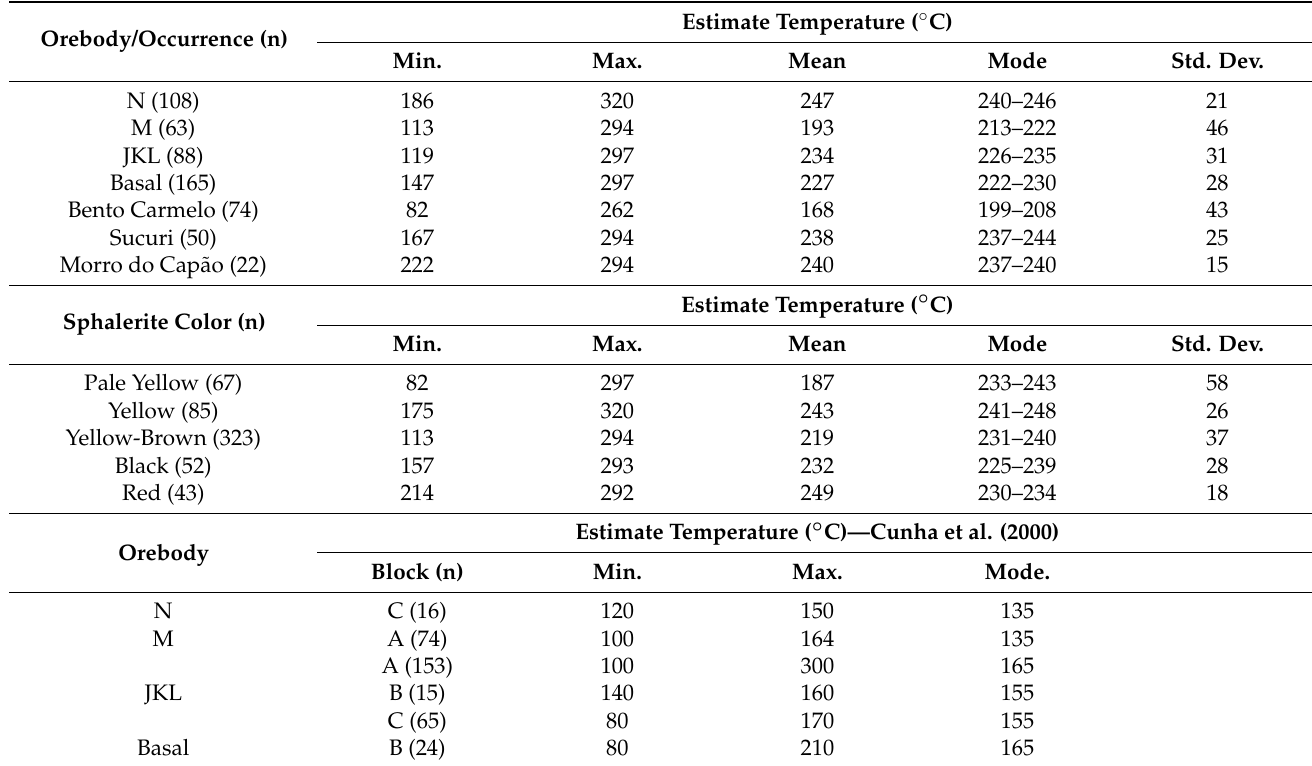
Table 6. Estimated temperatures of the Morro Agudo deposit and Sucuri, Bento Carmelo, and Morro do Cap ã o occurrences compared with fluid inclusion data from the Morro Agudo deposit [4]. (n) = number of samples. Blocks are defined by their proximity to the principal fault, with block A being the most proximal (see Figure